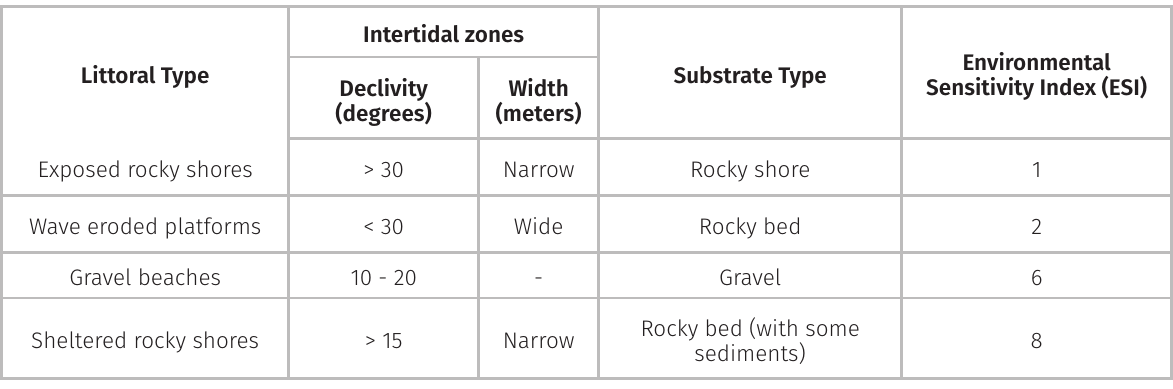
Table III. Geological and geomorphological characteristics of environments with rocky and granular substrate, according to the MMA (2004).